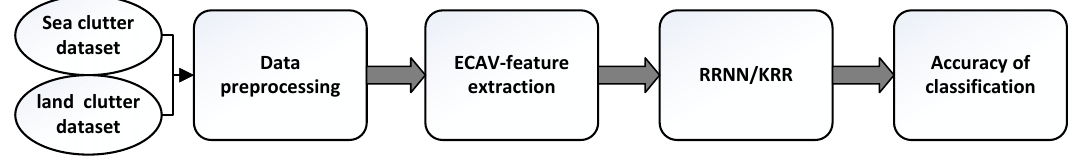
Figure 1. Flowchart of the proposed